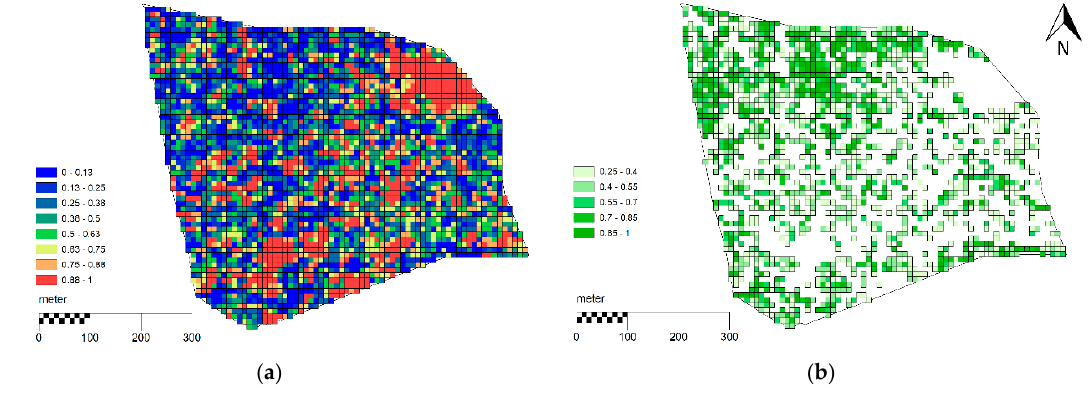
Figure 13. Treefall gap fuzziness map evaluated from the merged time series of 2015 and 2016 at the OS2 on a 10 m resolution grid. Reference treefall gap polygons are shown with black outline.